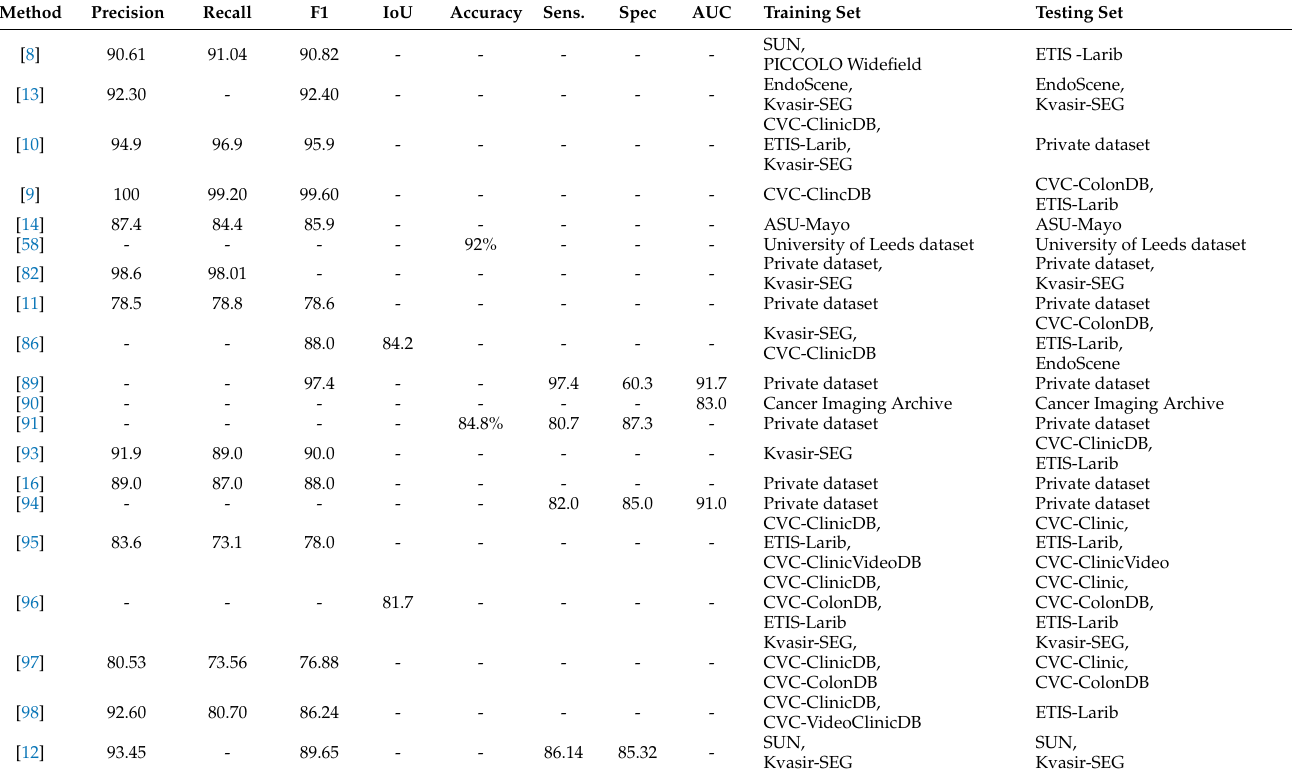
Table 3. A summary of all the reviewed